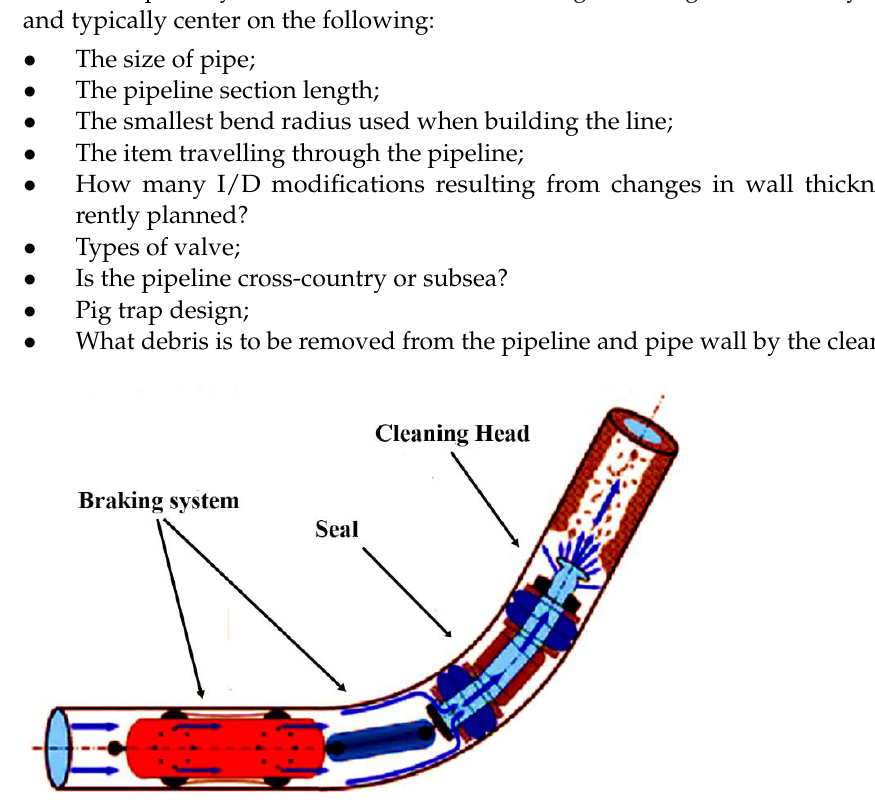
Figure 6. Pigging process [91].